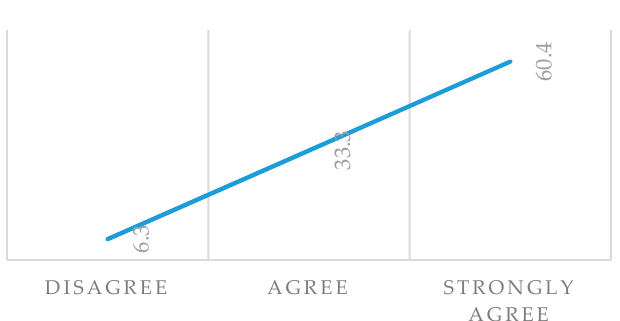
Figure 11. Results from Romanian informants for the item “I believe I am very integrated into Spain”.